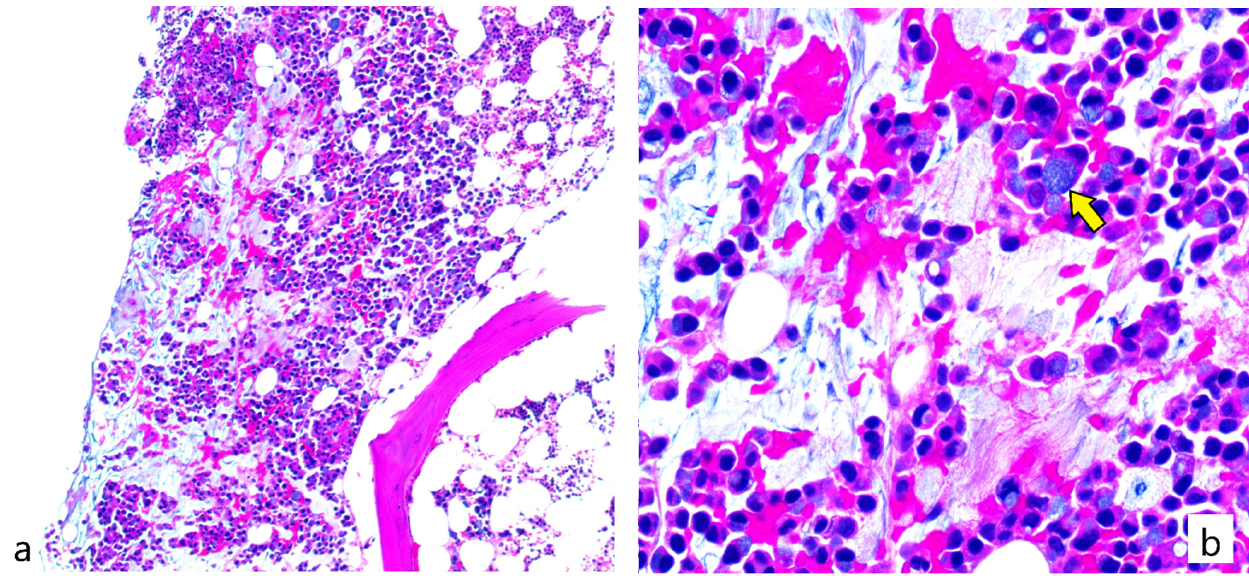
Figure 1. Bone marrow biopsy section showing ( a ) metastatic adenocarcinoma in the form of signet ring cells admixed within a background of bone marrow hemopoietic elements ( b ) Higher magnification showing signet ring carcinoma cells (pointed by yellow arrow) (H&E stain; ( a ): 100× magnification; ( b ): 400× magnification).